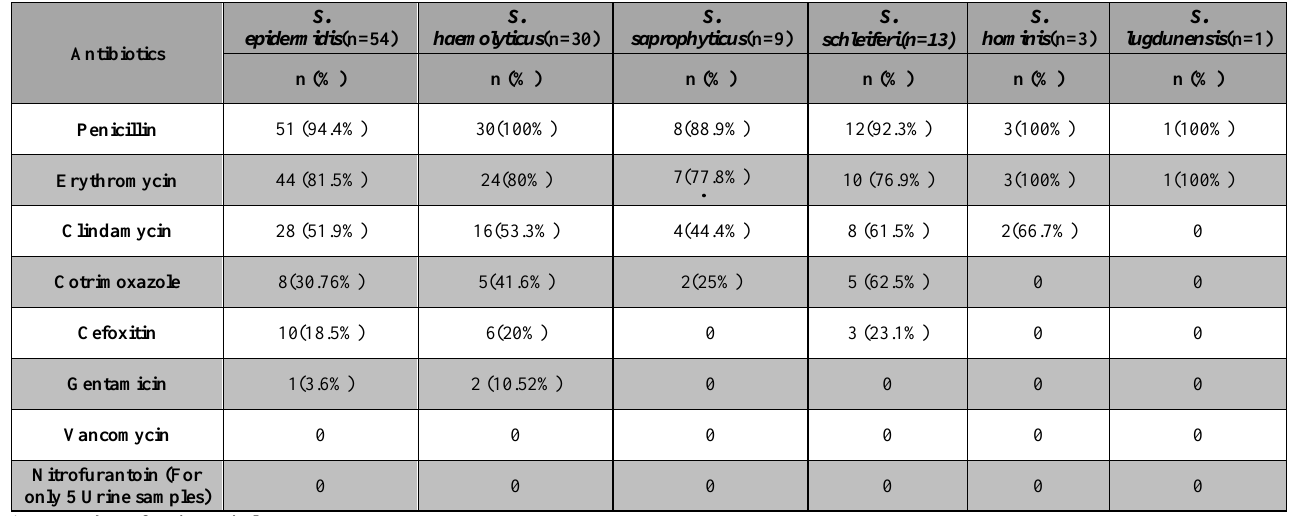
Table 6. Comparison of antibiotic resistance among the different strains.